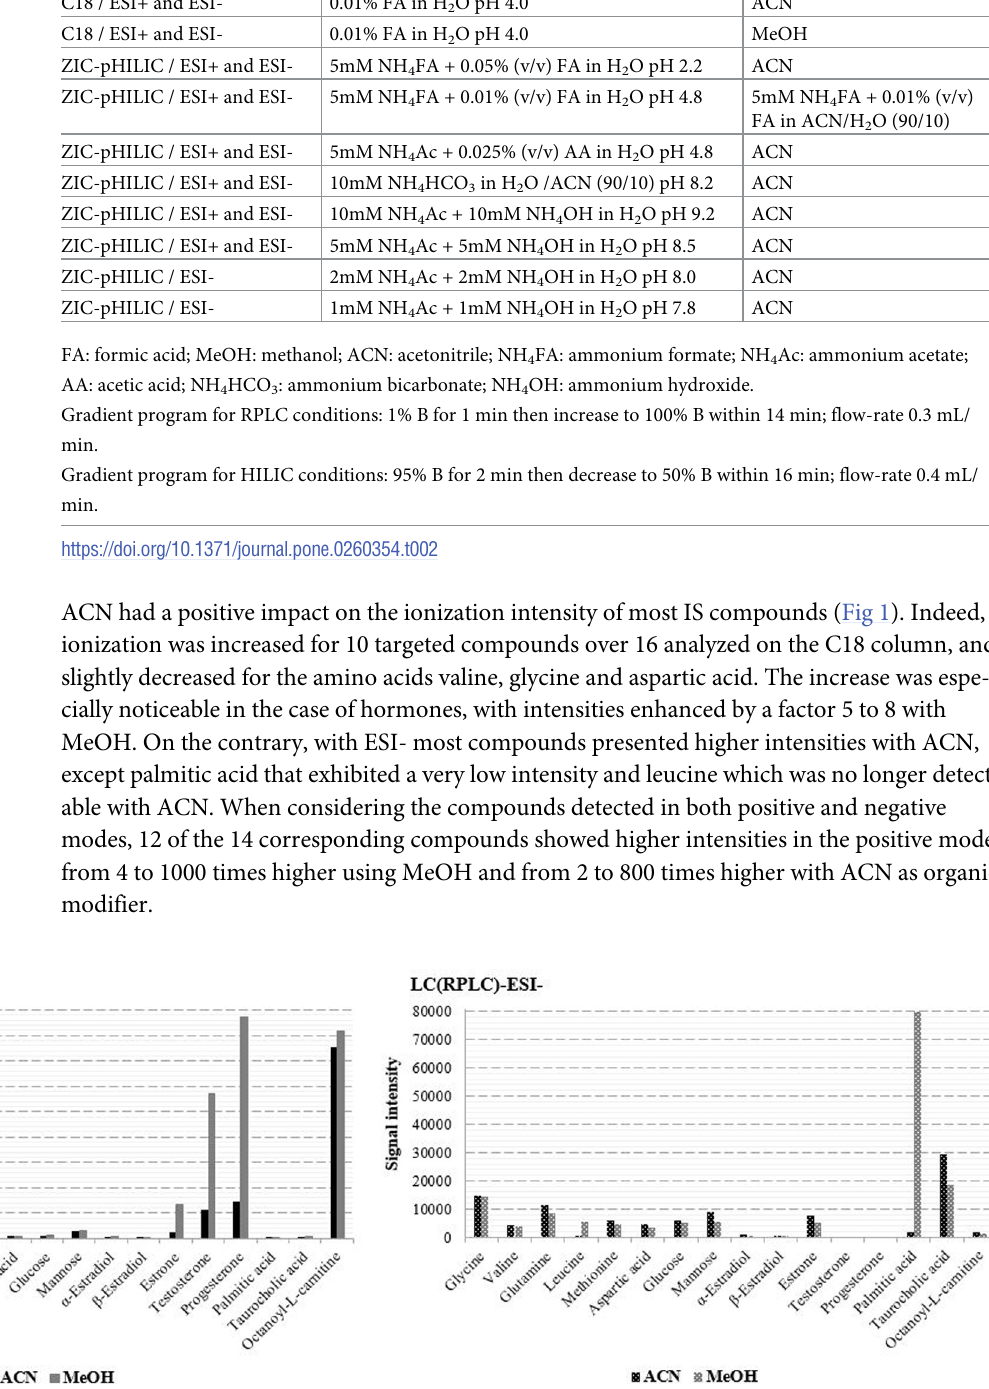
Fig 1. Intensities of targeted metabolites analyzed in LC(RPLC)-(ESI+/-)-HRMS conditions with MeOH or ACN as organic mobile phase B, after extraction of 50 mg of fish spiked at 500 μ g/L.